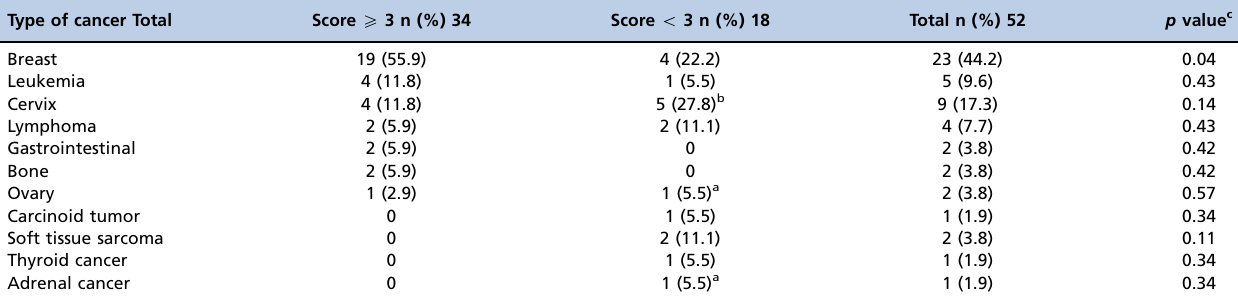
Table 4 - Type of cancer and risk score for VTE in pregnant patients hospitalized for clinical treatment and/or delivery (HC-FMUSP, 2016). Type of cancer